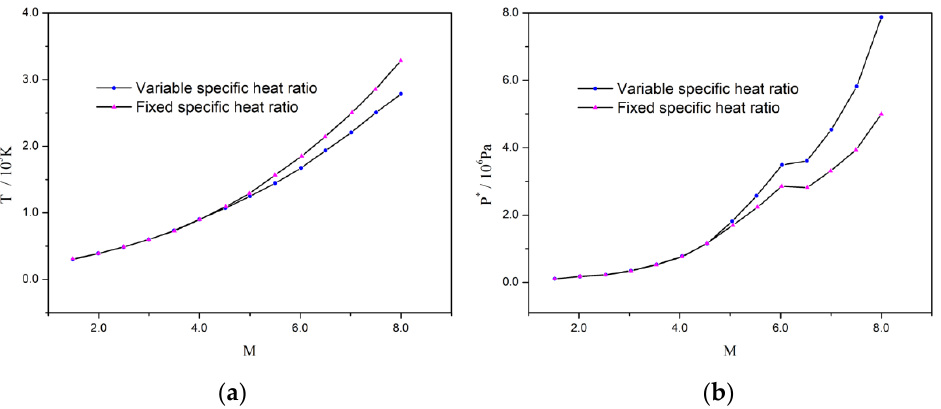
Figure 10. Results based on the fixed/variable specific heat ratio: ( a ) Total temperature T * distribu ‐ tion; ( b ) Total pressure P * distribution.